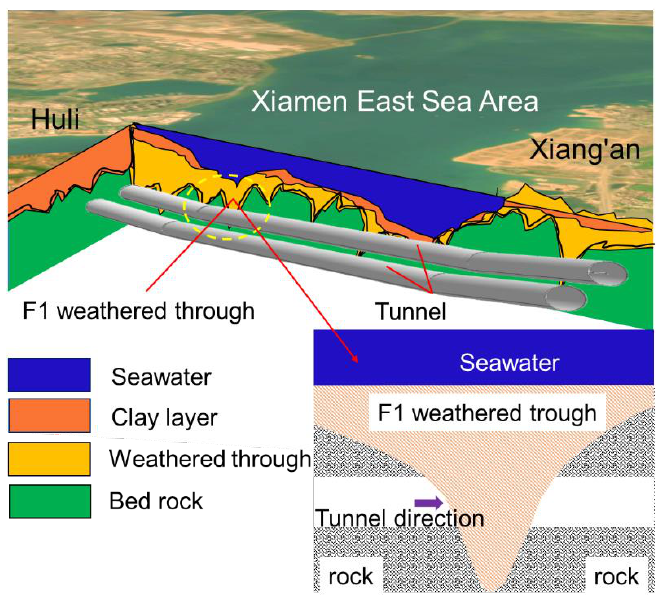
Figure 5. Relative position of Xiang ’ an Subsea tunnel and F1 weathering trough [19].